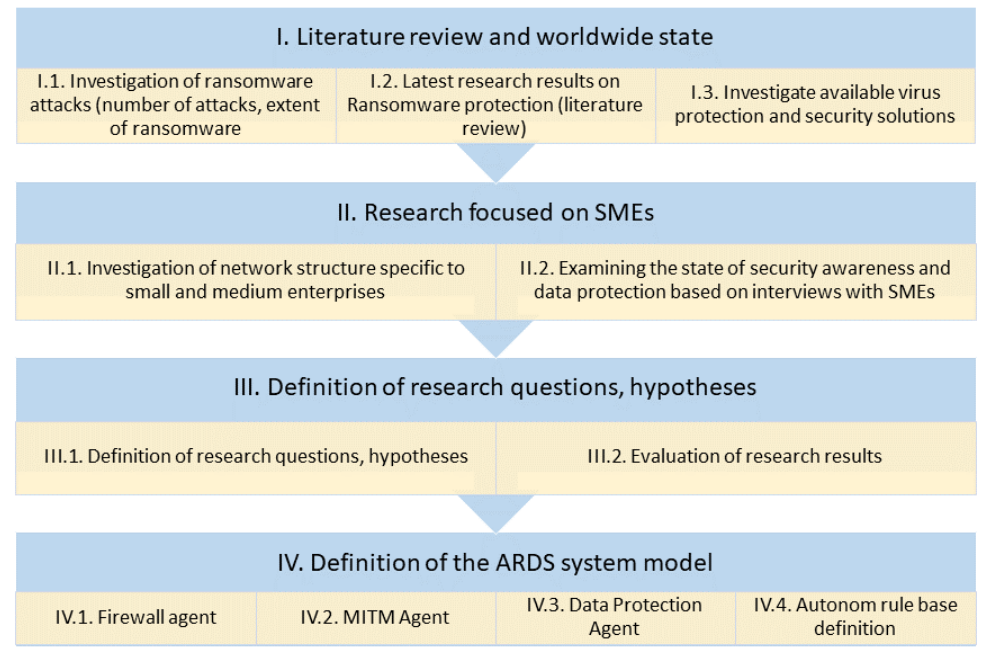
Figure 3. Visualization of research